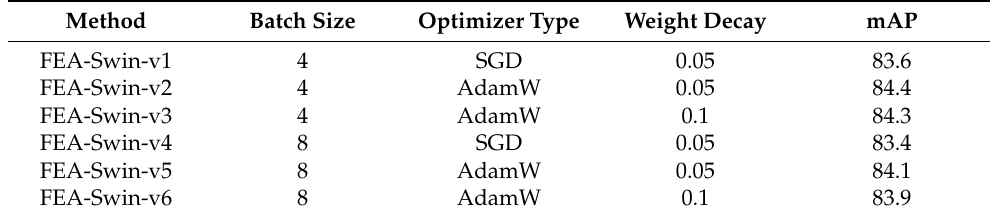
Table 5. Hyperparametric independence study for FEA-Swin on our self-collected dataset.